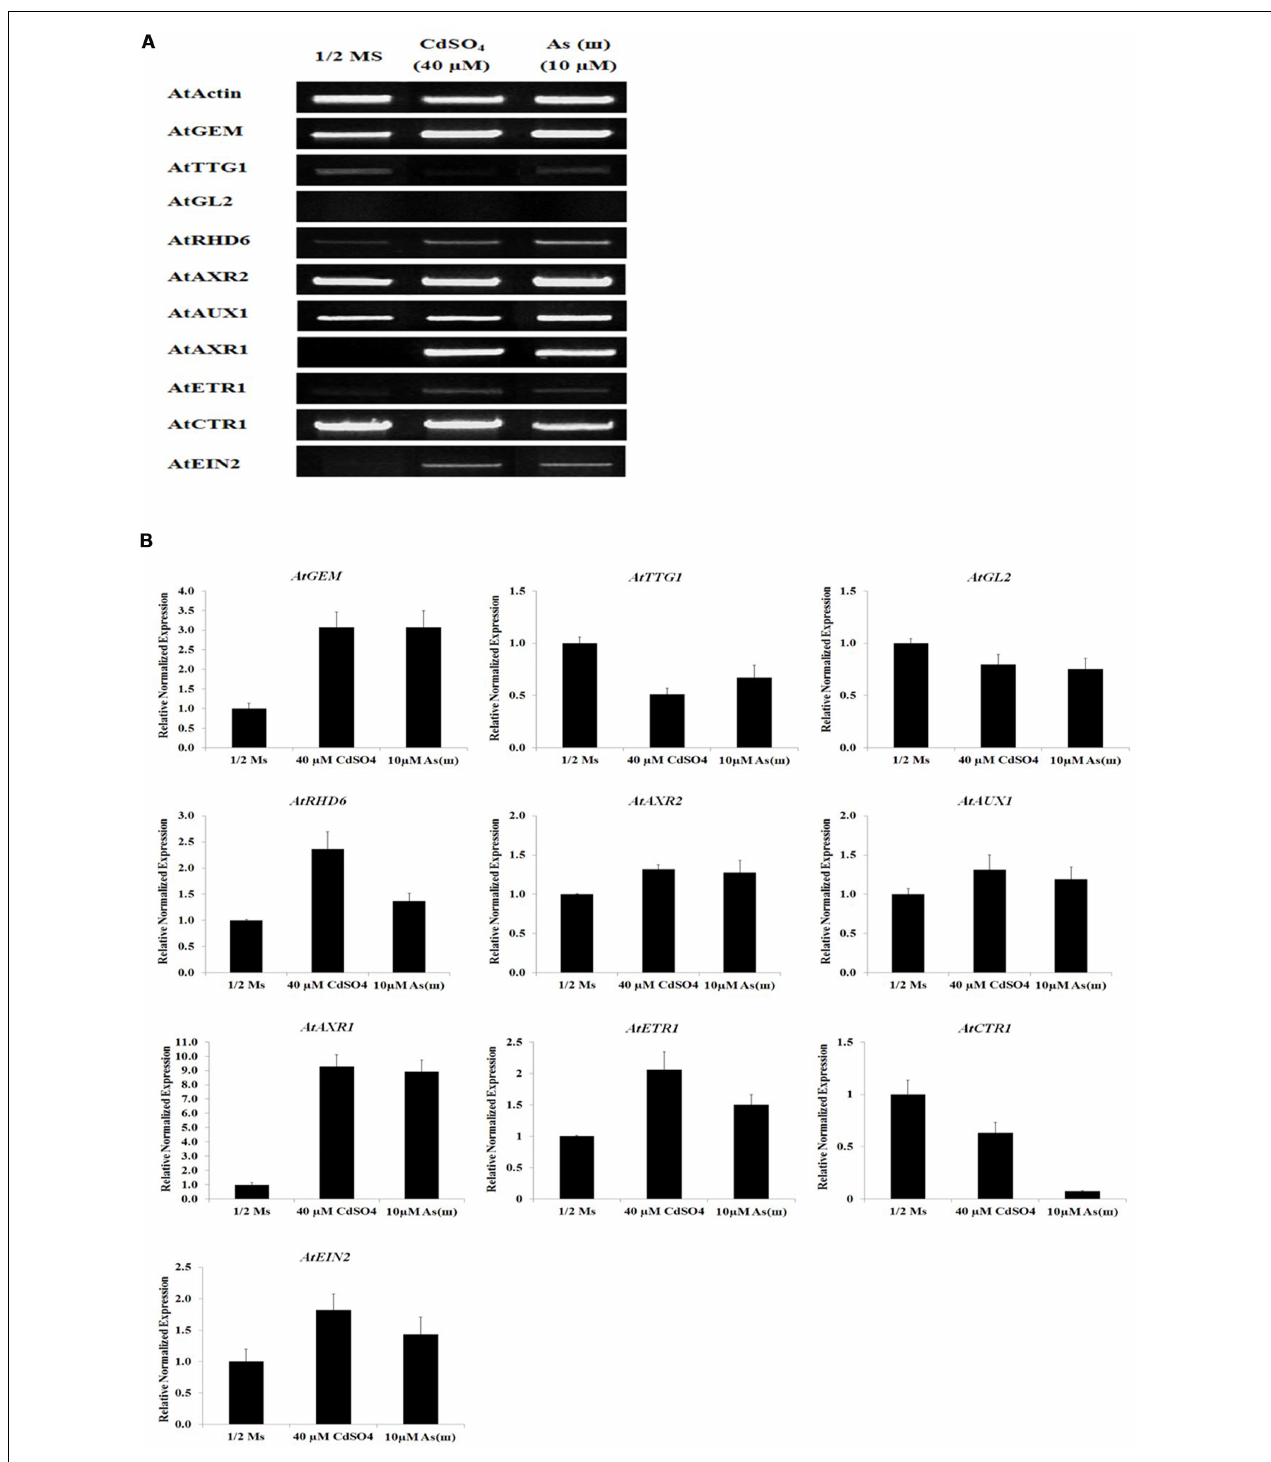
FIGURE 3 | Effect of Cd and As(III) on expressions of genes involved in the differentiation (fate determination) and elongation of root hairs in Arabidopsis . (A) Semi-quantitative RT-PCR results showing relative transcript levels of various genes involved in the differentiation ( GEM , TTG1 , and GL2 ), initiation ( RHD6 and ACXR2 ) and elongation ( AUX1 , AXR1 , ETR1, CTR1, and EIN2 ) of root hairs in response to Cd and As(III) in Arabidopsis . RT-PCR was performed using total RNA isolated from 1-week-old plants which were germinated and grown on 1/2 MS agar media treated with no metal, 40 µ M CdSO 4 and 10 µ M As(III).The gel photography represents 3 experimental replicates. (B) Quantitative real-time PCR results of various genes involved in root hair differentiation and elongation shown in (A) . Transcript levels were normalized to the transcript level of Actin .